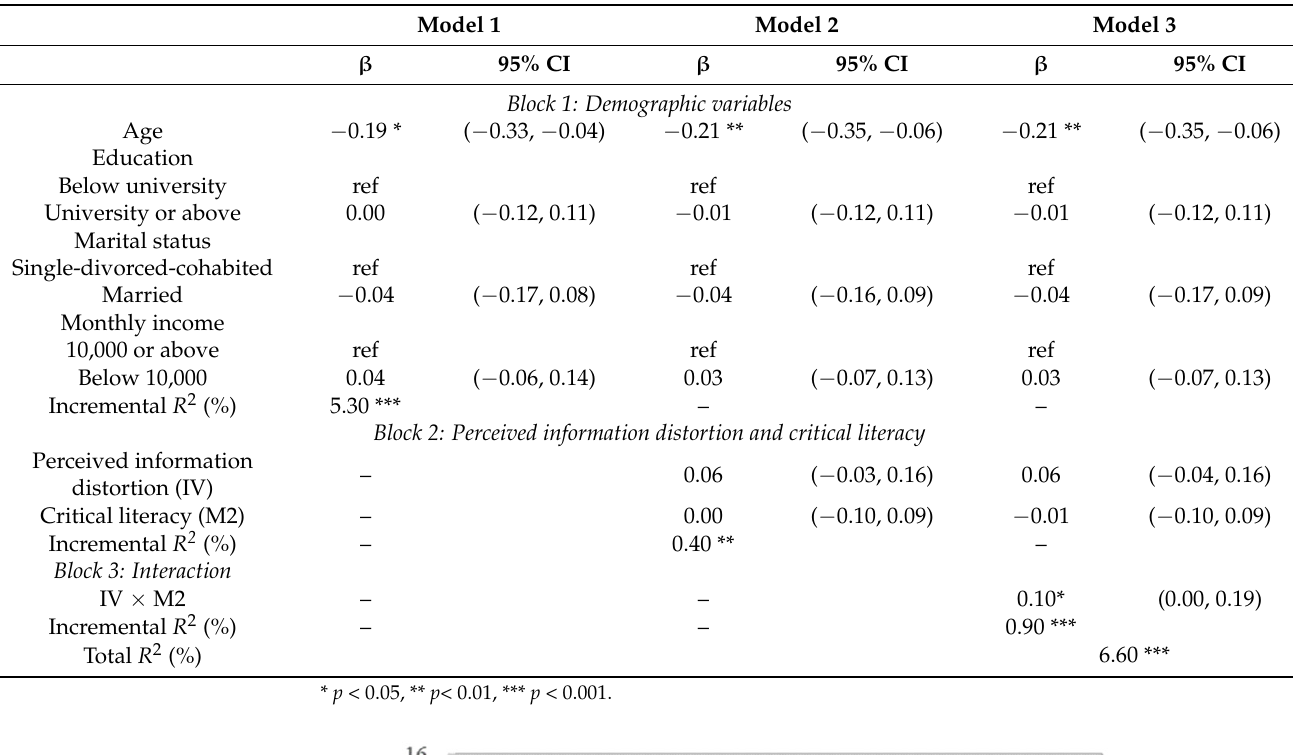
Table 4. Hierarchical regression analysis of perceived information distortion and critical literacy on addictive SMU (N = 411).